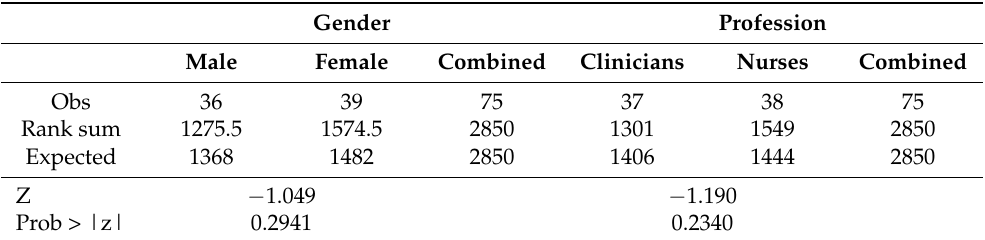
Table A1. The relationship between gender, profession and reported hand hygiene adherence among nurses and clinicians.